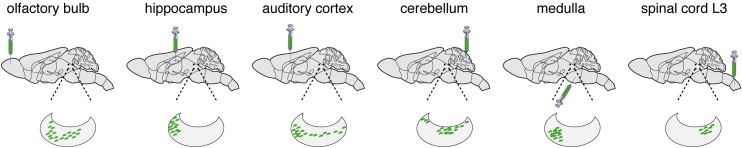
LC transduction. While working with the laboratories of Liqun Luo [100], Tony Pickering (Li et al., 2016; Hirschberg et al., 2017), and Johan Johansen (Uematsu et al., 2017), we have used the retrograde transport of CAV-2 vectors to characterize the connections and functions of the LC. Here we present some of the results showing LC connectivity as determined by CAV-2 retrograde transport. The green syringe shows where CAVGFP was injected. The kidney shaped blow up represents the LC and green dots are GFP positive soma.